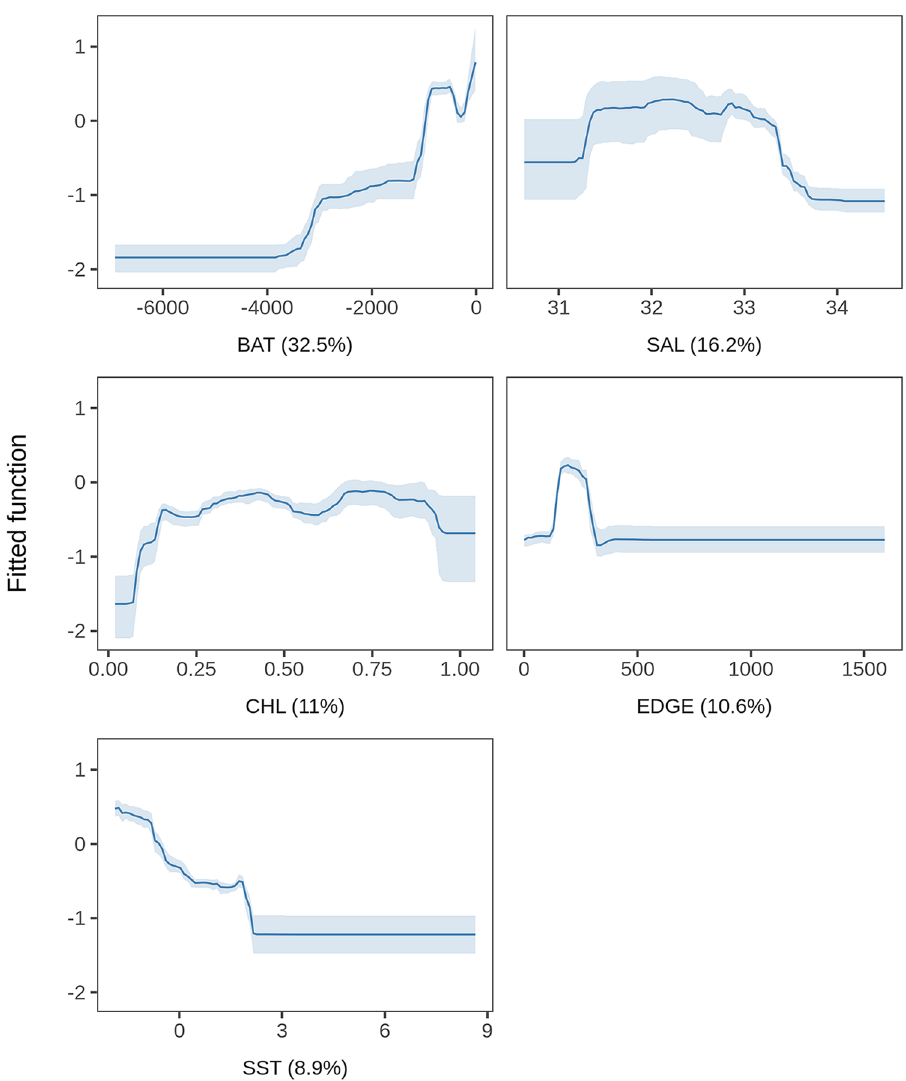
Figure 6. Partial dependence plots of the top five variables from the BRT model. Relative contribution in percentage is provided between parentheses for each variable. BAT: bathymetry, SAL: salinity, CHL: log- transformed (x + 1) concentration of chlorophyll-a, EDGE: distance from the sea ice limit, SST: sea surface temperature. The shading shows the 95% confidence intervals estimated from 50 bootstrap samples of the data